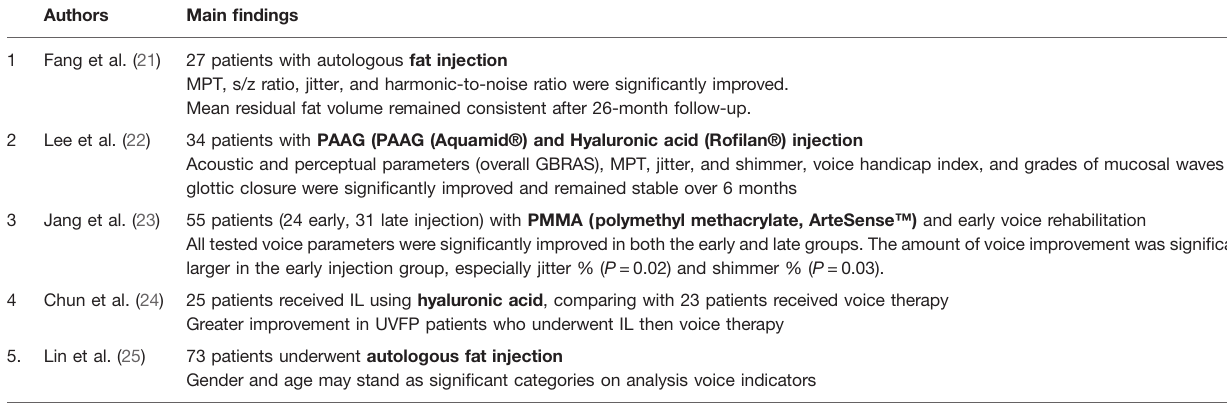
TABLE 1 | Summary for the literatures focus on the management of UVFP after thyroid surgery with IL. Authors